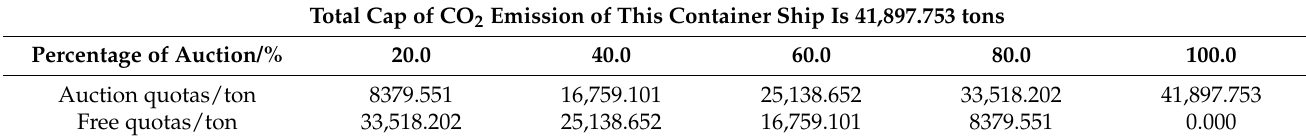
Table 5. Quota allocation of CO 2 cap for the container ship under different scenarios in 2060.